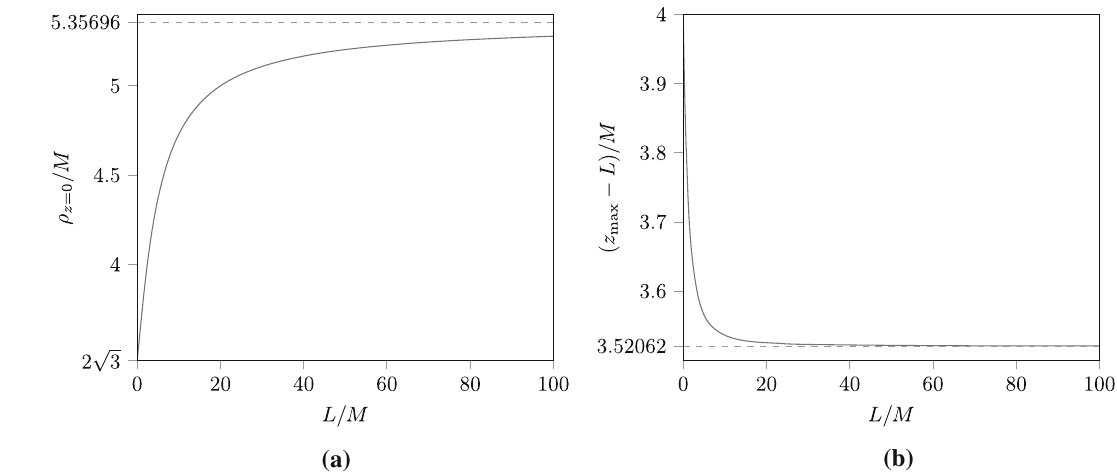
Fig. 6 Plot of a ρ z = 0 against L , and b z max − L against L , for the class of polar FPOs. These plots asymptotically approach the dashed lines shown. The dashed line in a corresponds to the value ρ z = 0 (cid:11) 5 . 35696 M , while that in b corresponds to z max (cid:11) L + 3 . 52062 M